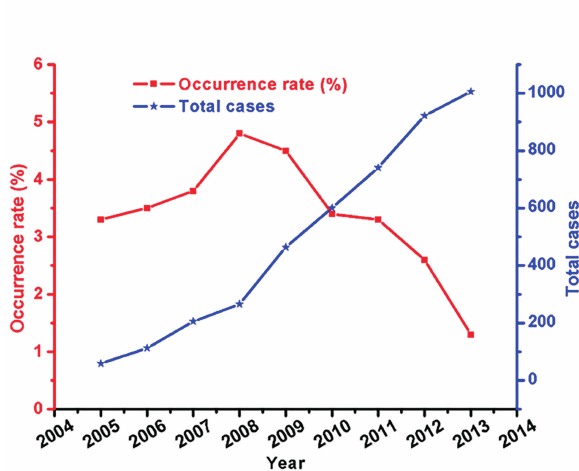
Figure 3 - The intraoperative serious complications and total cases by the year from